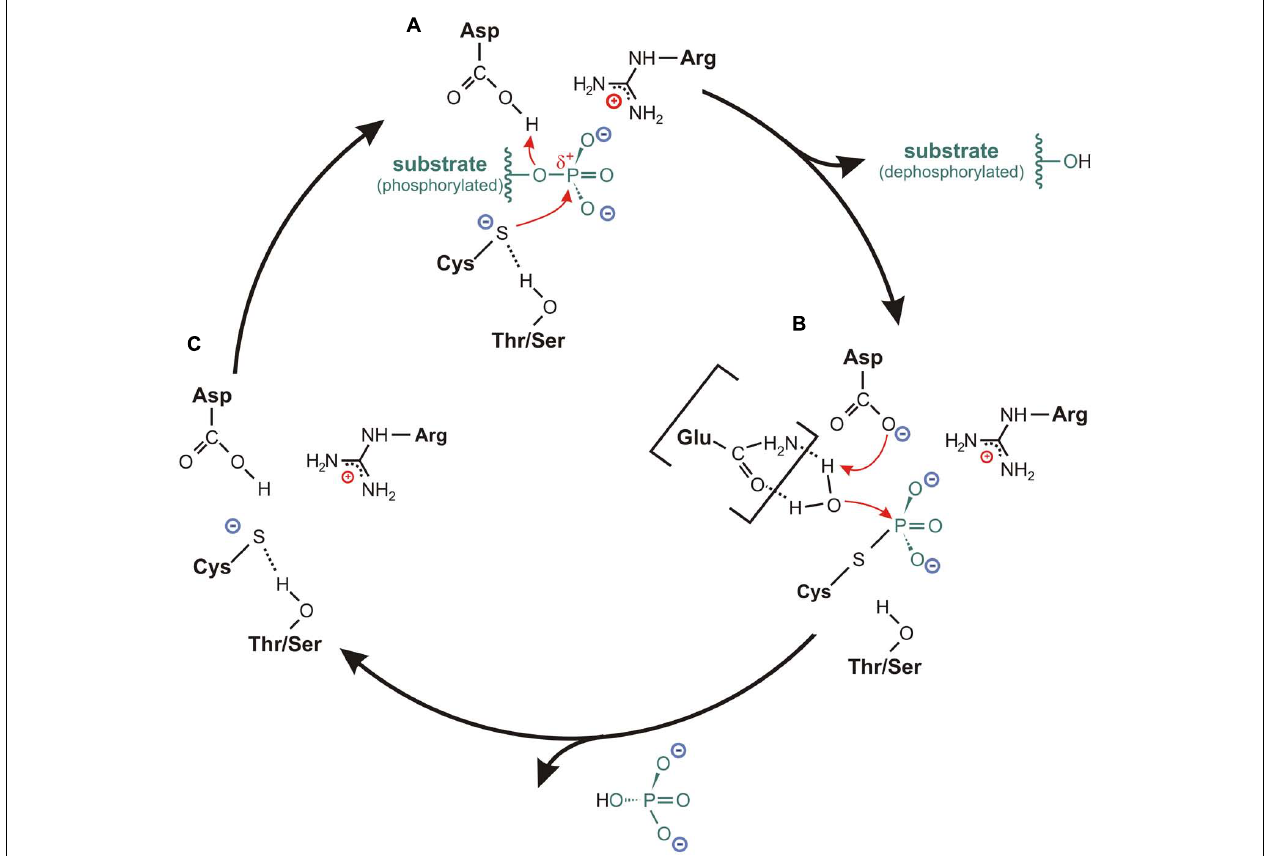
FIGURE 4 | Catalytic cycle for cysteine-based PTPs. (A) In the resting state, the sulfur of the catalytic cysteine is stabilized in an anionic thiolate form. This is mediated by a hydrogen bond between the sulfur and the hydroxyl oxygen of the conserved Thr-/Ser-side chain located in the P-loop. Upon binding of the substrate, where the P-loop arginine is particularly involved in the positioning of the substrate, the thiolate acts as catalytic nucleophile by attacking the phosphorus atom of the substrate. The formation of a cysteinyl-phosphate intermediate is facilitated by a general acid (usually an aspartate from the WPD- or DPYY-loop flanking the active site), which donates a proton to the substrate leaving group. Subsequently,